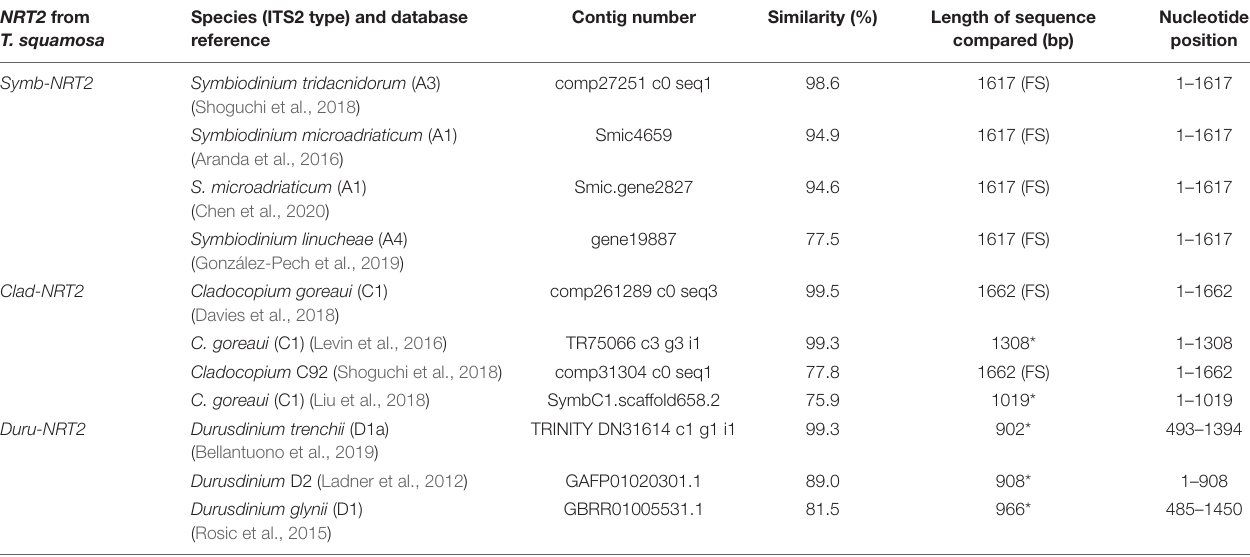
TABLE 1 | A comparison of the nucleotide sequence of nitrate transporter 2 ( NRT2 ) derived from Symbiodinium ( Symb-NRT2 ), Cladocopium ( Clad-NRT2 ), or Durusdinium ( Duru-NRT2 ) of Tridacna squamosa with selected NRT2 contigs obtained from various symbiotic dinoflagellate databases, with information on the species/ITS2 type, database reference, contig number and the length of the sequence for comparison of selected NRT2 contigs. NRT2 from T. squamosa